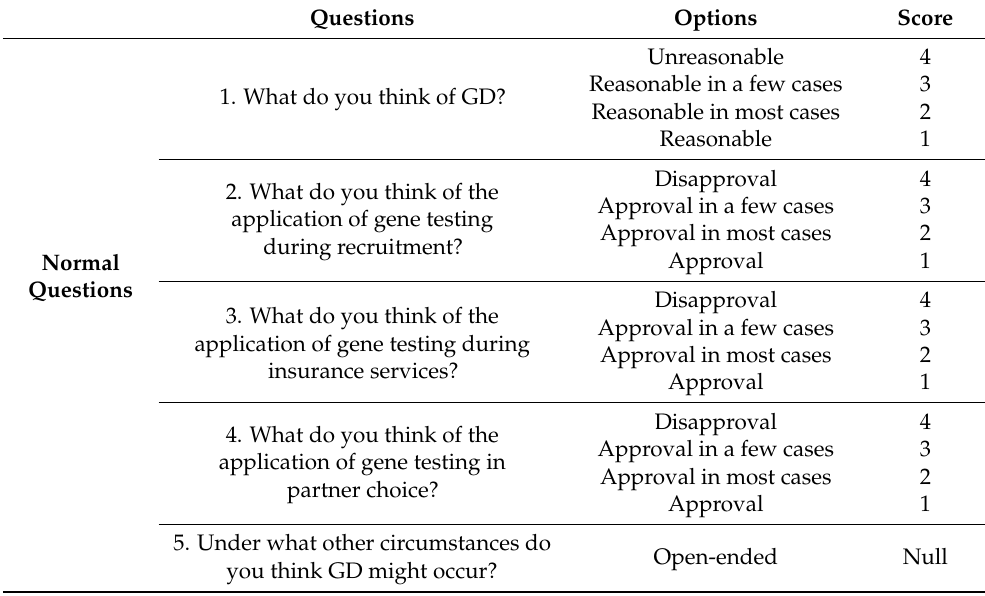
Table 1. The overall setting of the